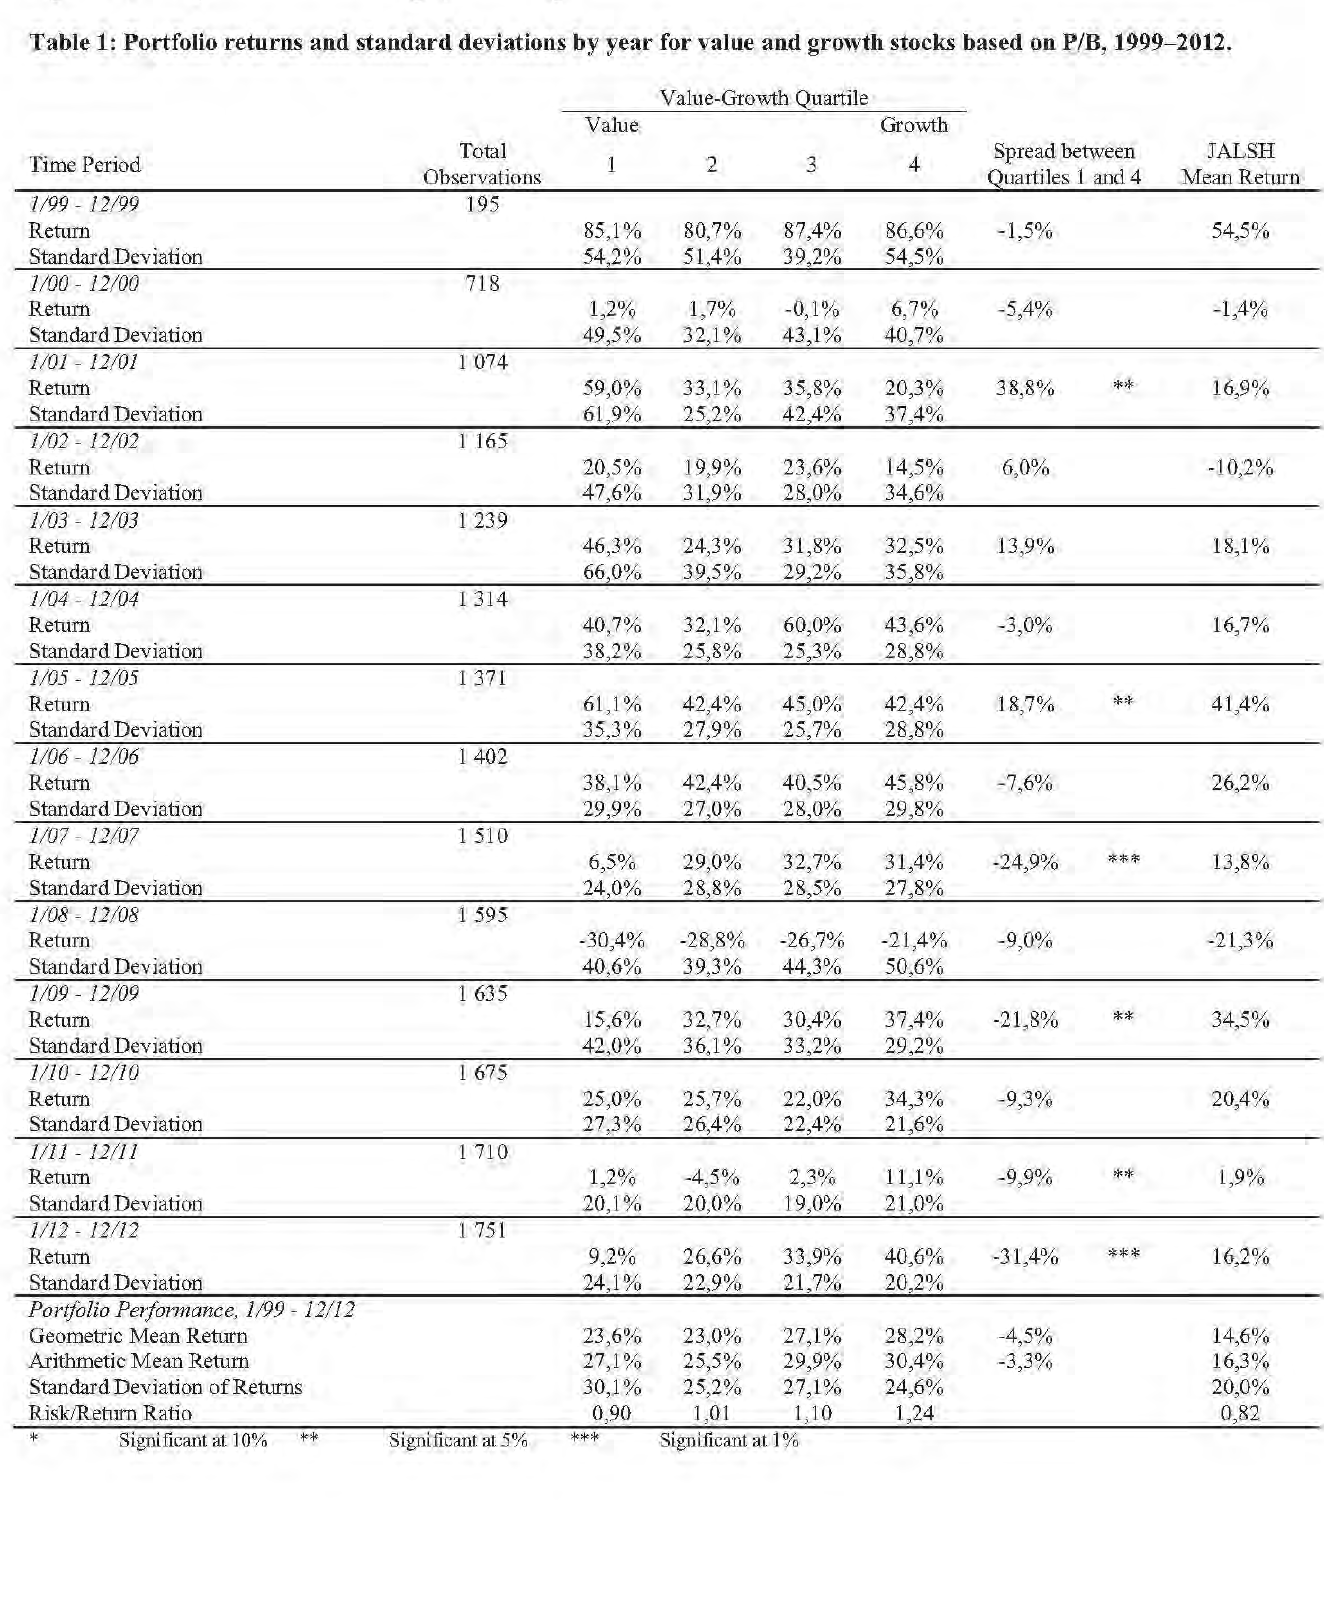
Table 1: Portfolio returns and standard deviations by year for value and growth stocks based on P/B,